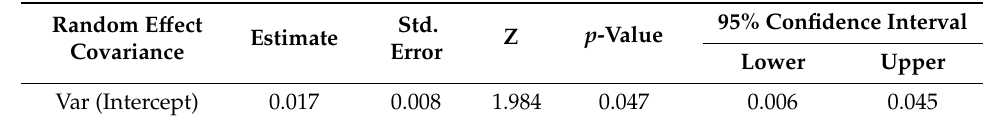
Table 4. Random e ff Table 4. Random effect.